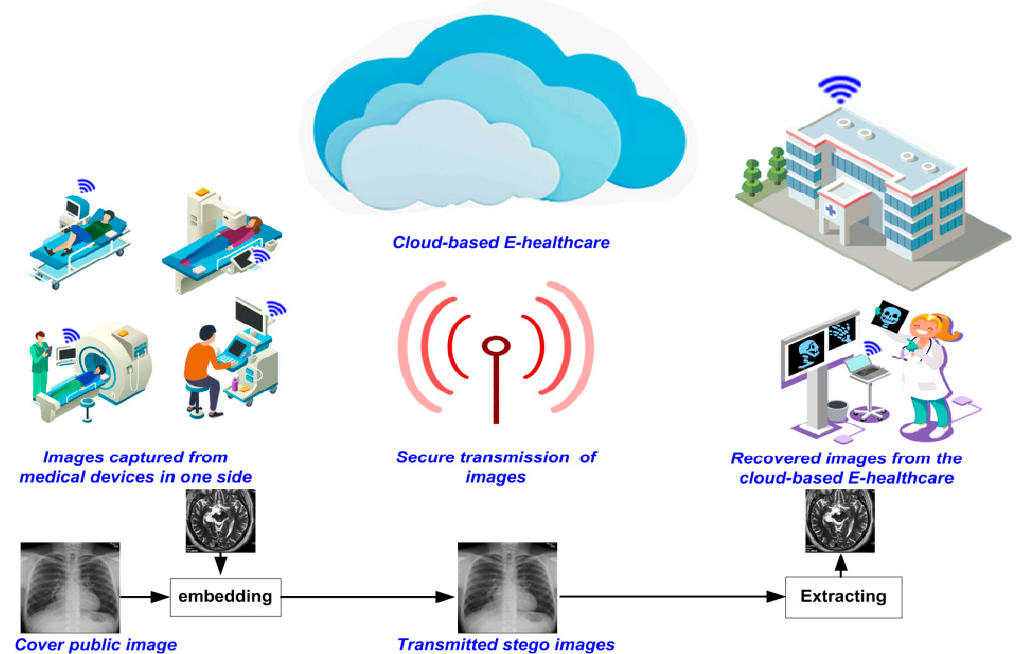
Figure 1. General framework envisioned for secure image transmission on cloud-based E-healthcare platforms. Figure1.